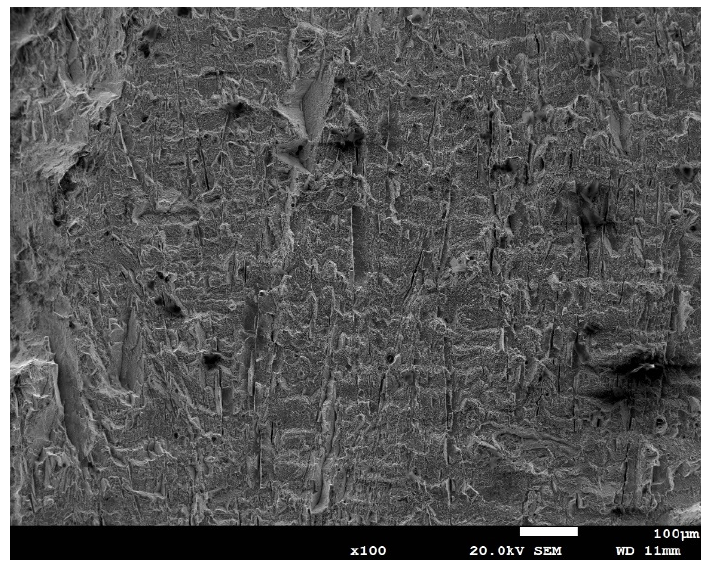
Figure 11. Fracture surface of specimen N7.